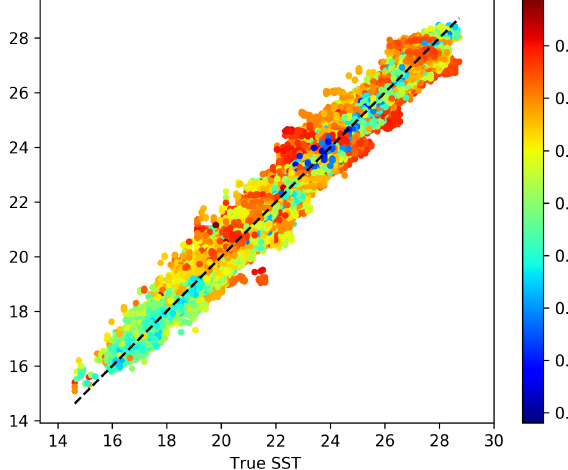
Figure 5. Scaled errors are computed as the difference between the reconstructed SST and the actual measured SST (withheld during cross-validation) divided by the expected standard deviation